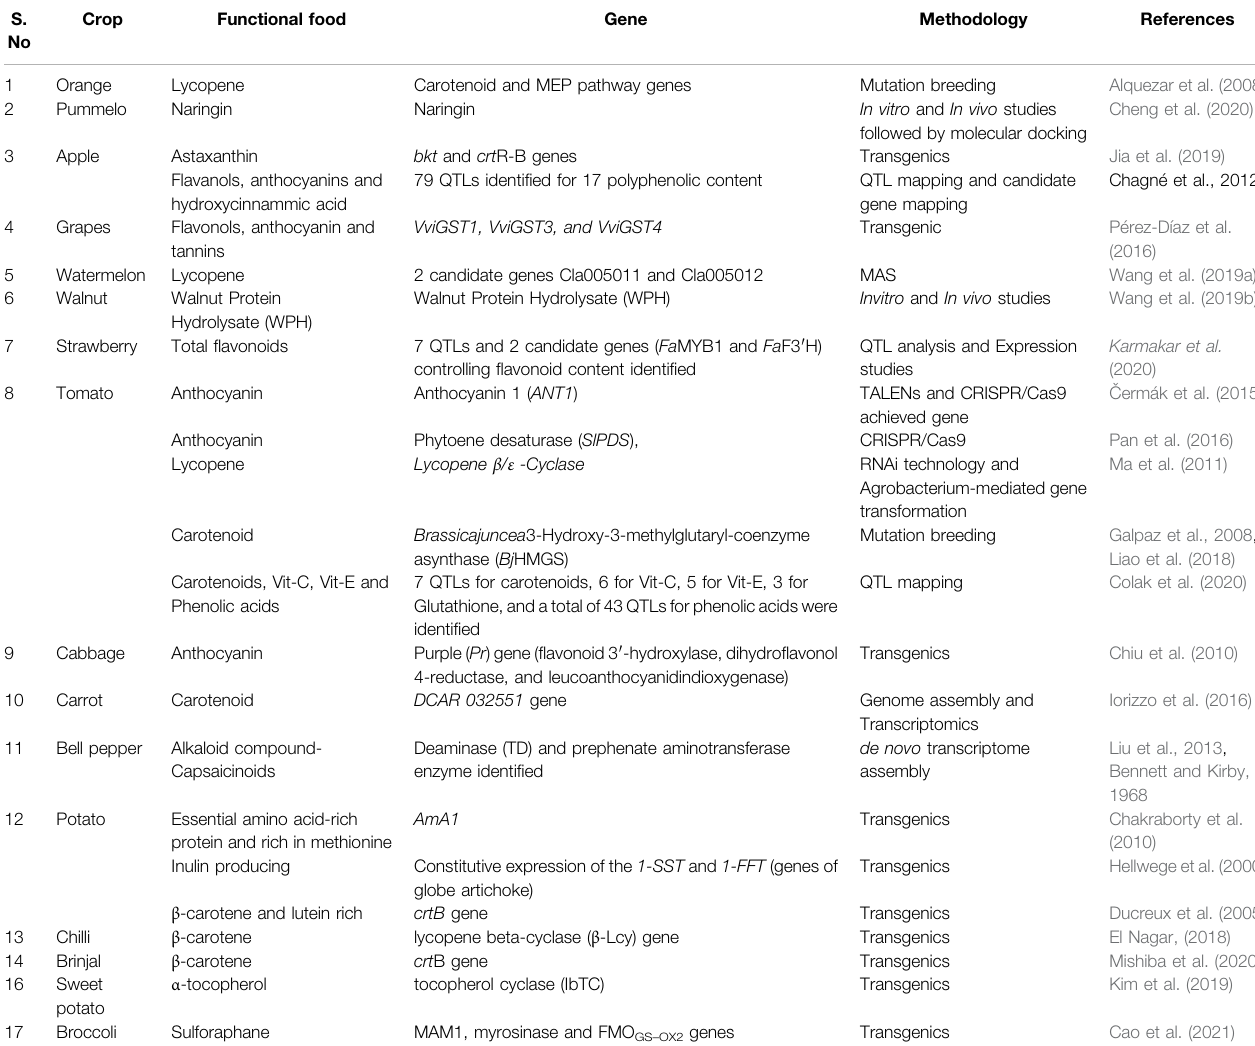
TABLE 4 | Study of functional foods in fruits and vegetables using biotechnological